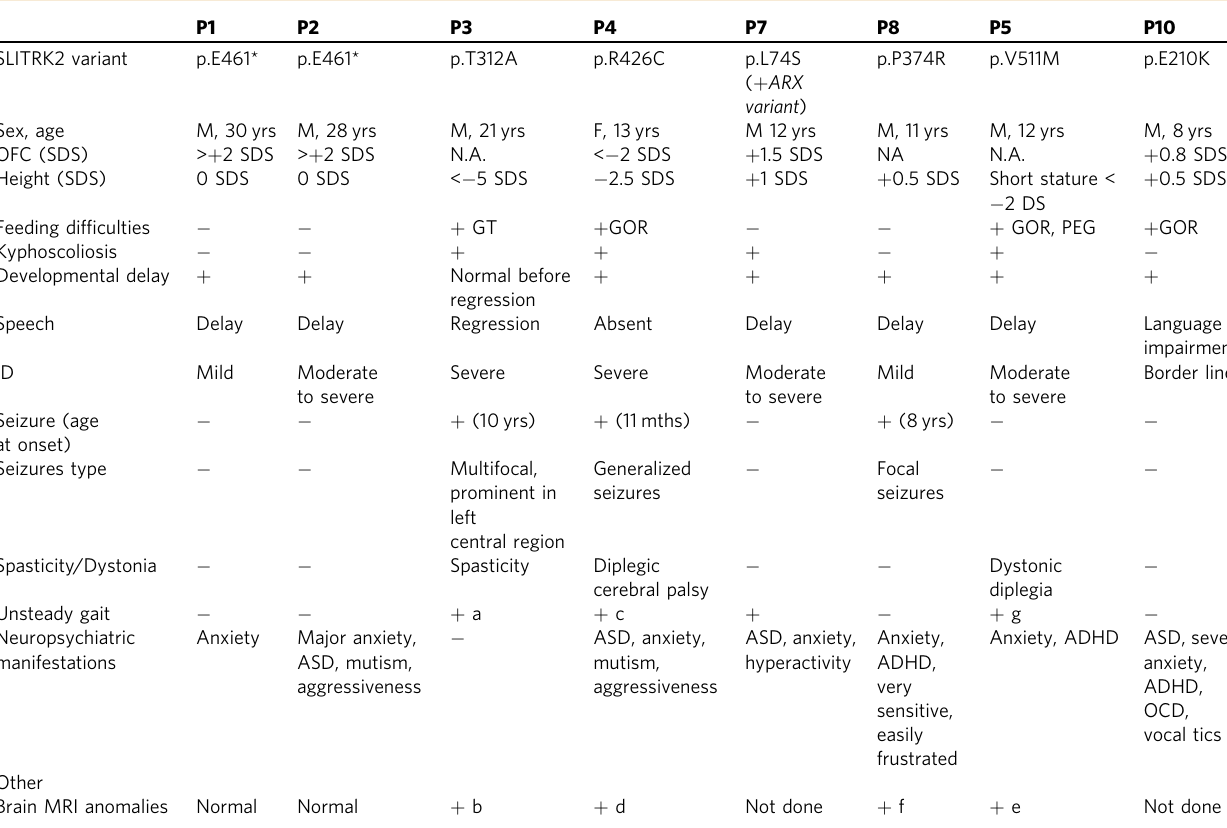
Table 1 Clinical manifestations identi fi ed in individuals harboring potential disease-causing SLITKR2